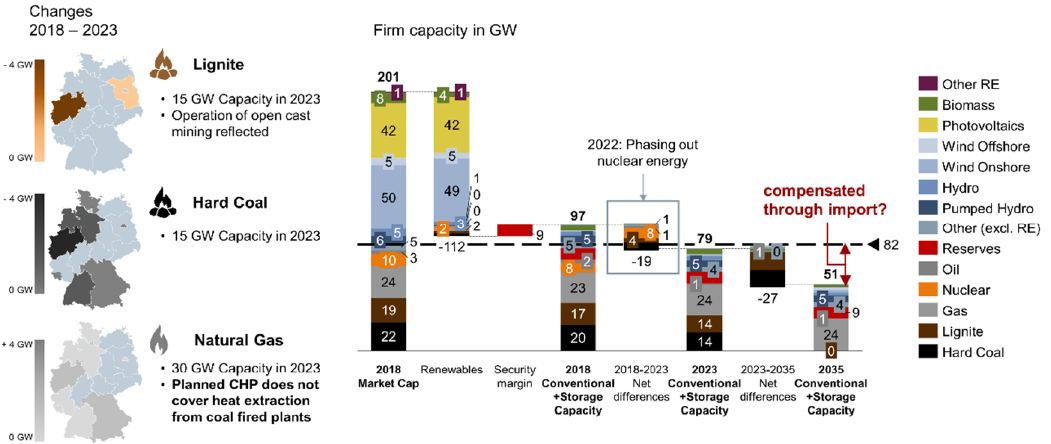
Figure 5. Change in capacities of conventional generation and resulting gap between peak load and sum of conventional generation.